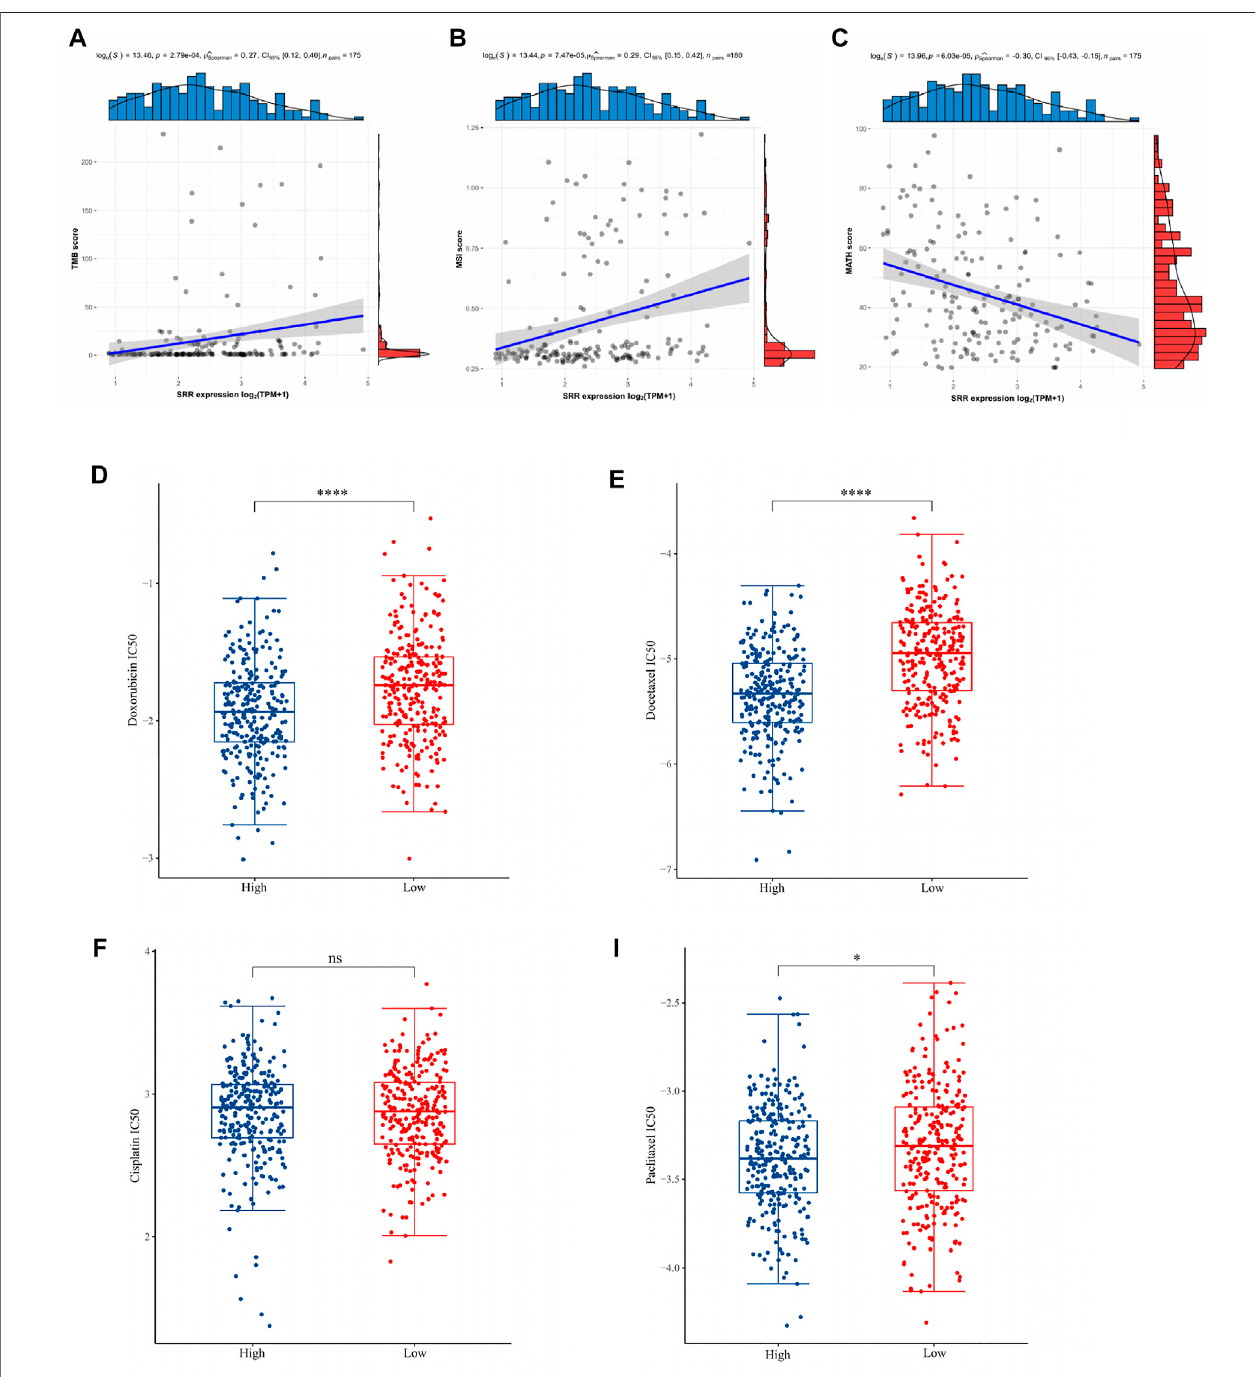
FIGURE 4 | Associations of TMB, MSI, MATH, and chemotherapeutic drug sensitivity with SRR expression in UCEC. (A – C) Scatterplots display the Spearman correlation between SRR expression and TMB (A) , MSI (B) , and MATH (C) scores in UCEC. The abscissa represents the expression distribution of SRR gene expression, and the ordinate is the expression distribution of the TMB/MSI/MATH scores. The density curve on the right represents the TMB/MSI/MATH score, and the upper-density curve represents the SRR gene expression distribution trend. (D – I) Chemotherapy drug sensitivity analysis. The blue and red color represent the UCEC SRR-high expression and SRR-low expression group, respectively. The ordinate represents the distribution of the IC50 score of doxorubicin (D) , docetaxel (E) , cisplatin (F) , and paclitaxel (I) . * p < 0.05, **** p < 0.001, ns denotes not signi fi cantly different.